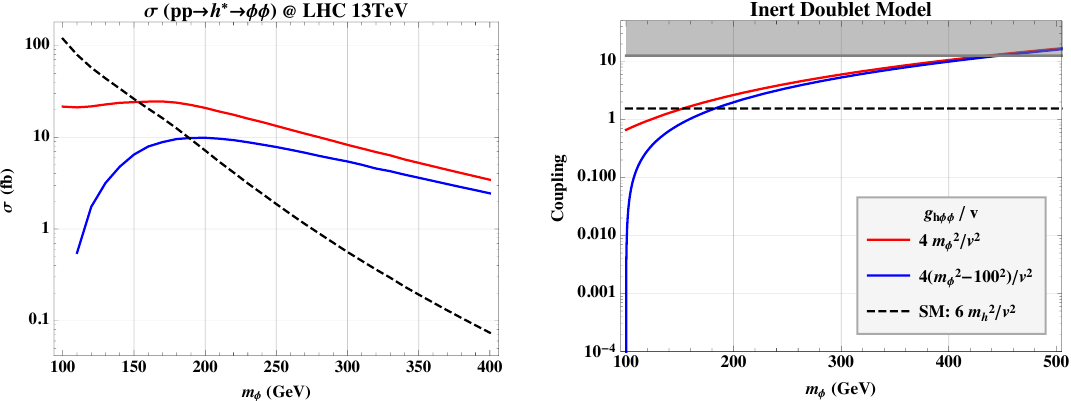
Figure 1. Left panel shows examples of the production cross section of gg ! h (cid:3) ! (cid:30)(cid:30) . Di(cid:11)erently colored curves assume di(cid:11)erent choices of couplings, which are shown in the right panel. The gray region indicates the strong coupling regime where the theory loses perturbativity. Analytical expressions are taken from ref.